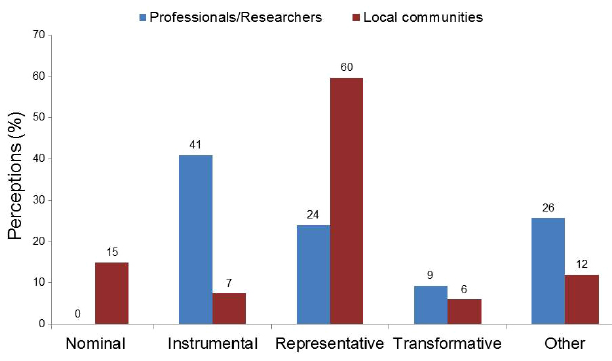
Fig. 4 . Professionals/researchers’ (n = 171) and local communities’ (n = 67) perceptions of participatory environmental monitoring, by types of participation described by White